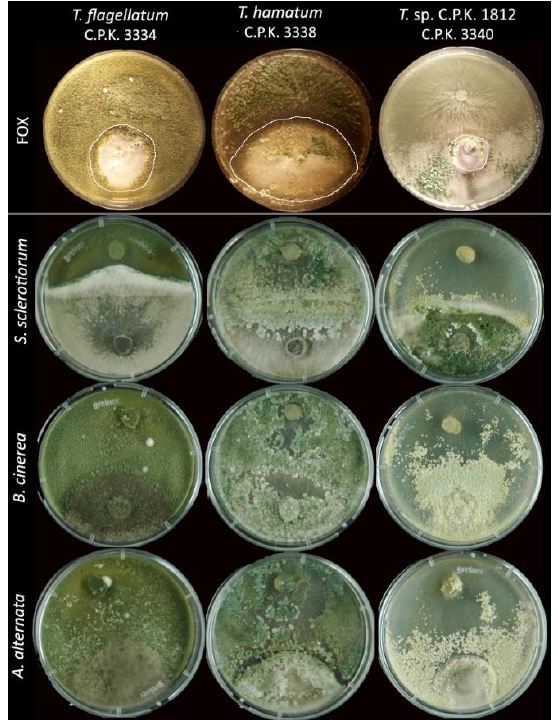
Figure 3. Dual confrontation plates with Trichoderma strains (always above) against four plant pathogens (always below). White lines show the extension of FOX